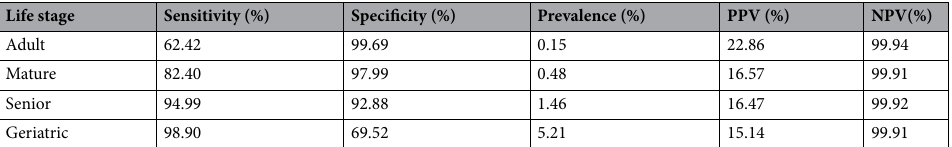
Table 2. CKD prevalence, model sensitivity, specificity, positive predictive value and negative predictive value estimates for CKD prediction at the time of diagnosis for different life stage groups. Adult is defined as 1.5 to 6.5 years, mature as 6.5 to 9.75 years and under, senior 9.75 to 13 years, and geriatric as over 13 years. Disease prevalence is estimated from the life stage groups within the study population and model performance determined using the test data set.